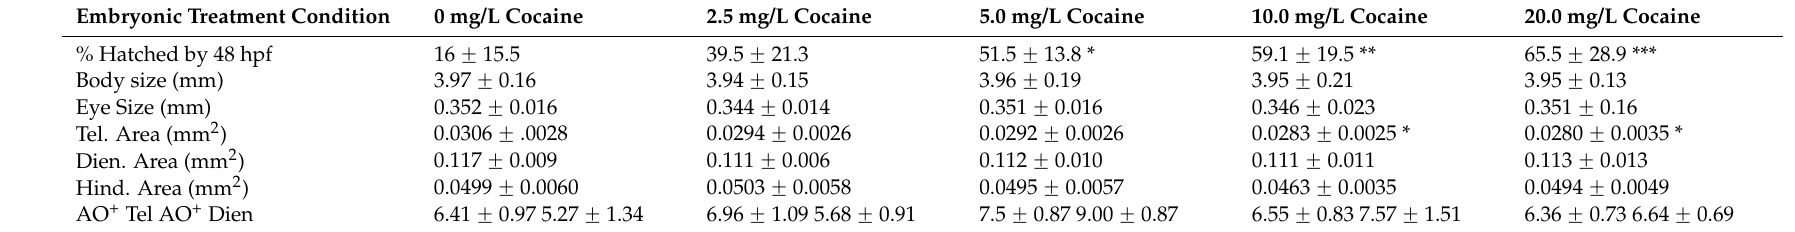
Table 1. Morphometry of embryonic zebrafish clutches treated with cocaine. Larval fish treated with different doses of cocaine were inspected for percentage of hatched individuals at 48 h post fertilization (hpf) and then imaged for size analysis at 5 days post fertilization (dpf) One-way ANOVA with Dunnett’s post-test was used to compare embryonic treatment groups to the untreated control fish. For percentage hatched, values were arcsin transformed before statistical evaluation, p < 0.0001, F = 7.69, df = 47, * p < 0.05, ** p < 0.01, and *** p < 0.001 when compared to untreated fish. For body size p < 0.9651, F = 0.145, and df = 214. For